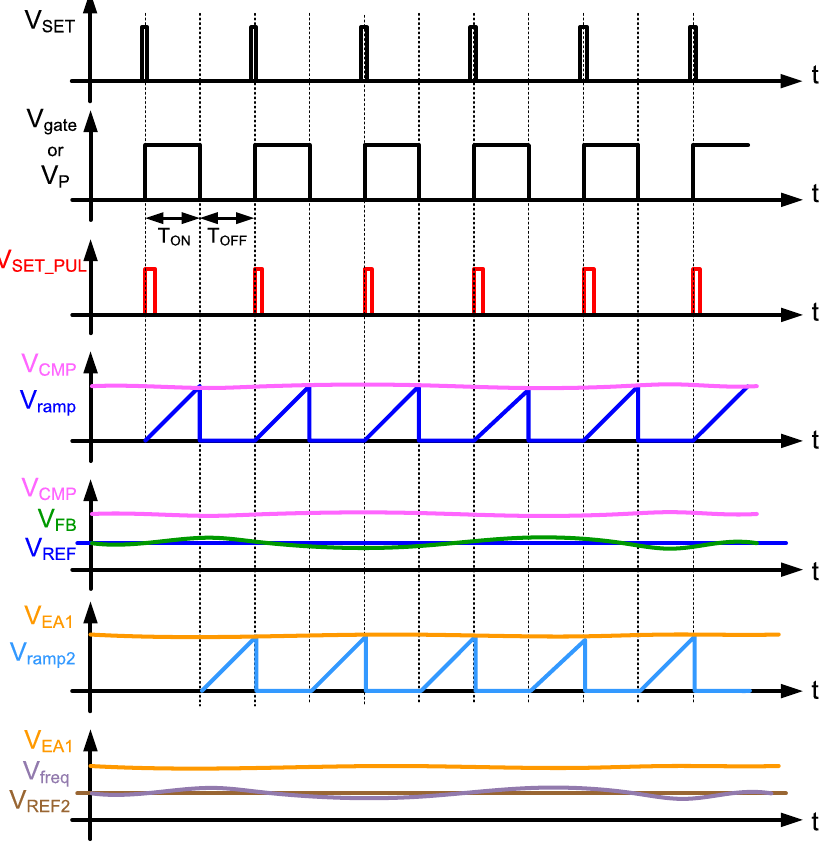
Figure 4. Key waveforms of the proposed converter.